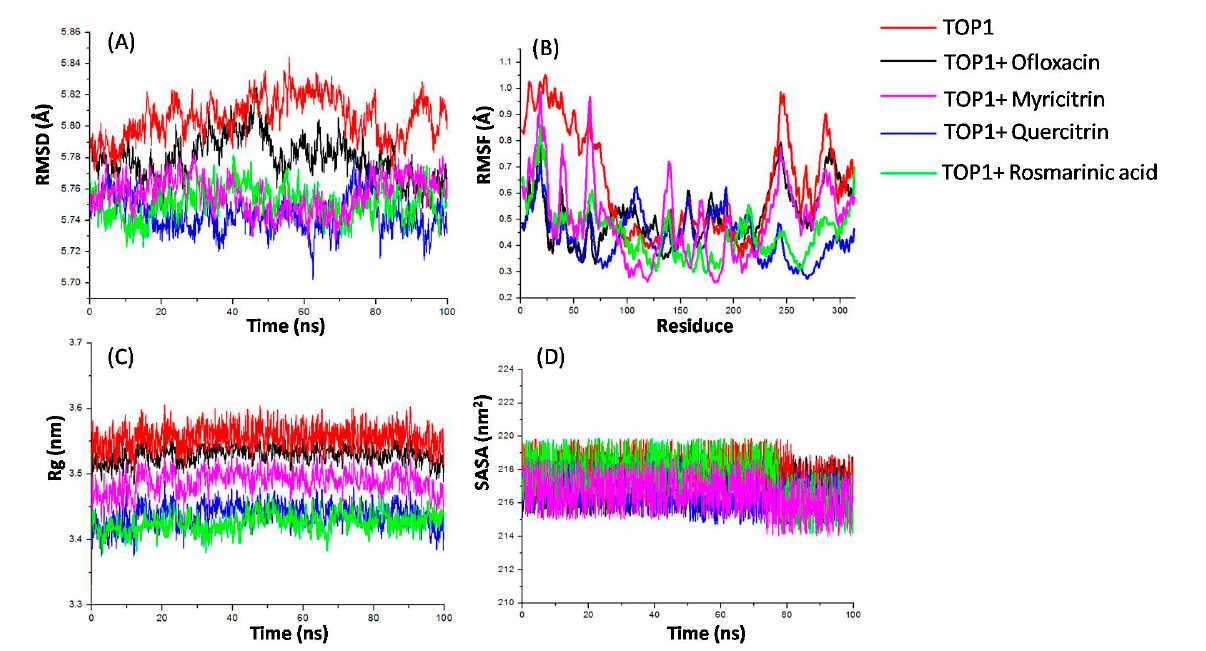
Figure 4. Root mean square deviation (RMSD), root mean square fluctuation (RMSF), radius of gyration (Rg), and solvent-accessible surface area (SASA) graphs of the TOP1–ligand complexes produced over a 100 ns molecular dynamics simulation. ( A ) RMSD versus time plot of TOP1–ligand complexes; ( B ) analysis of the RMSF trajectories of residues of TOP1–ligand complexes; ( C ) Rg versus time plot of TOP1–ligand complexes; ( D ) SASA versus time plot of TOP1–ligand complexes; as for the unbound protein, TOP1, TOP1+Ofloxacin, TOP1+Rosmarinic acid, TOP1+Myricitrin, and TOP1+Quercitrin are represented as red, black, purple, blue, and green, respectively.